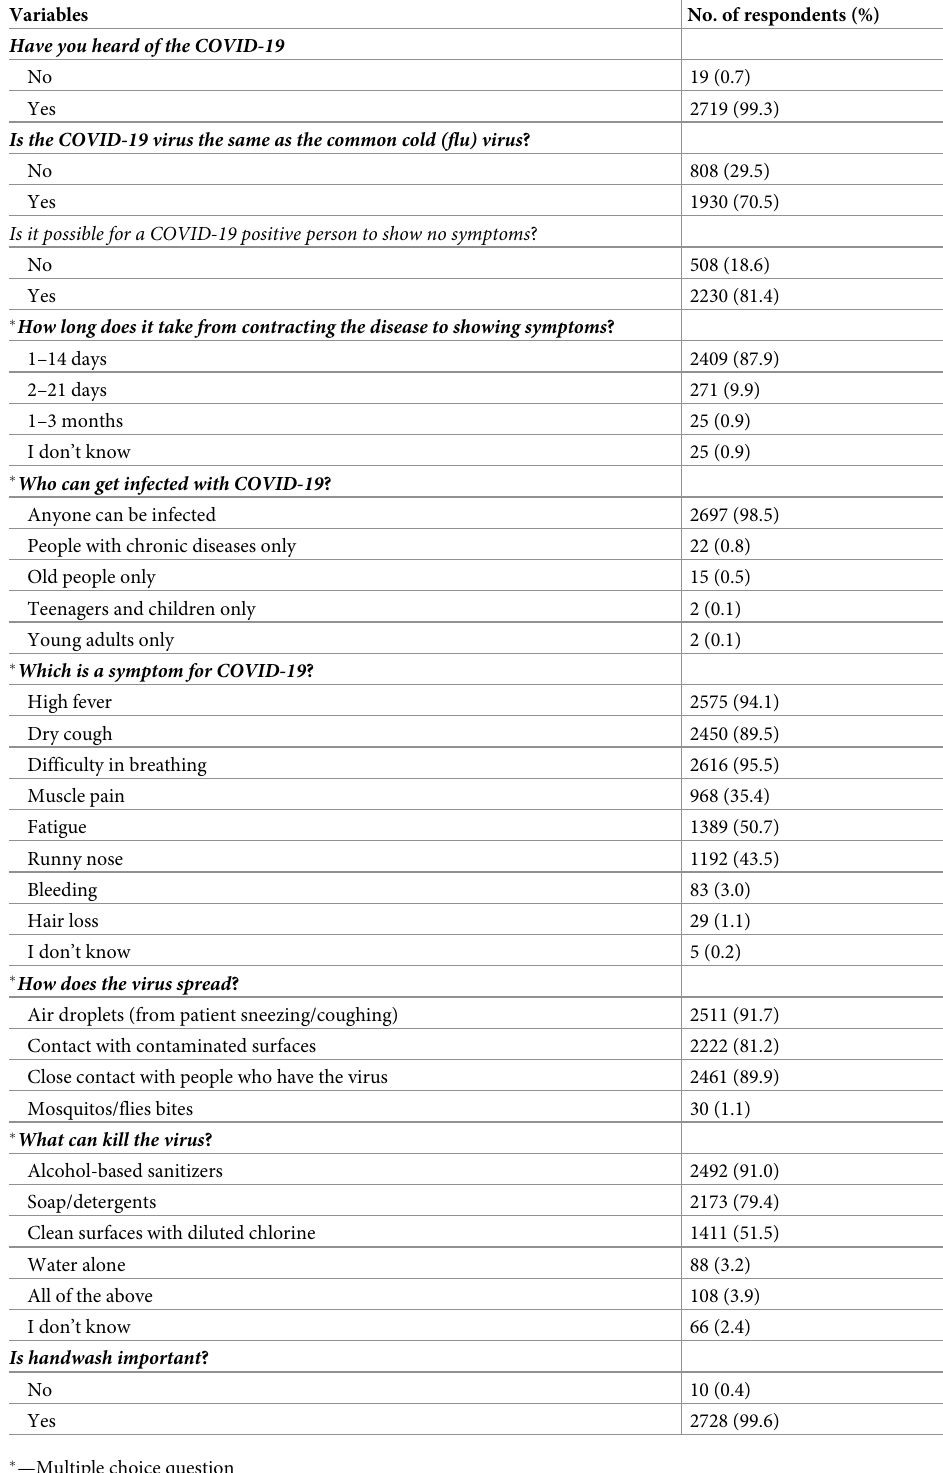
Table 3. Knowledge of respondents about the COVID-19 pandemic in the three regions.